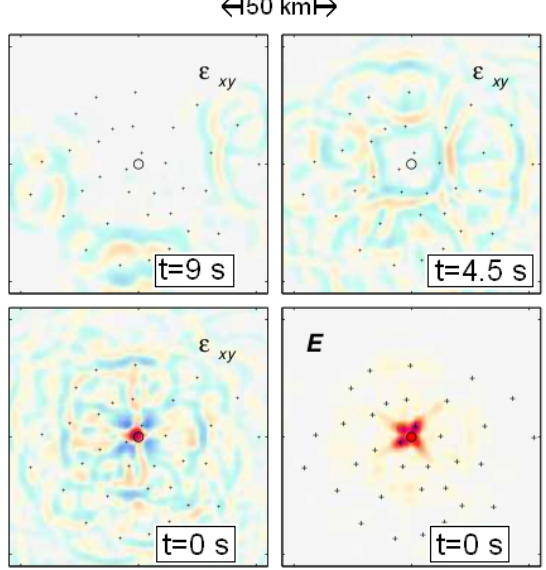
Fig. 3. Snapshots at the point-source depth (12 . 5km) of the time- reversed strain field (cid:15) xy at different times, and the energy 1 (lower right) at t = 0.